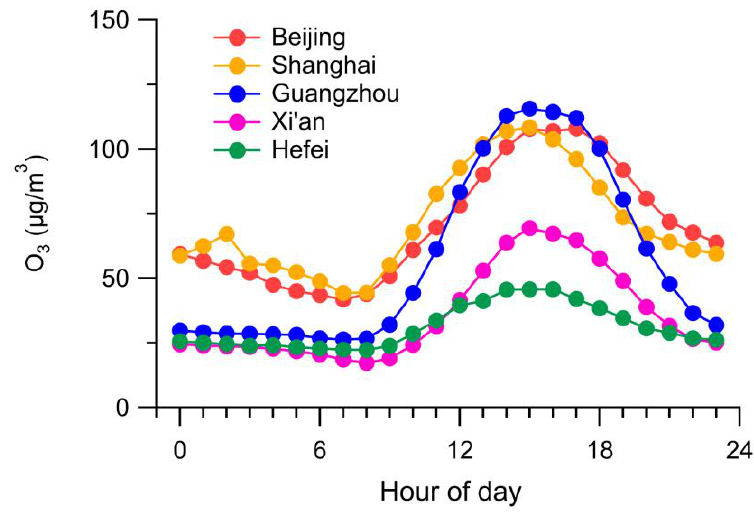
Figure 4. Diurnal variations of hourly O 3 concentrations in the five cities.